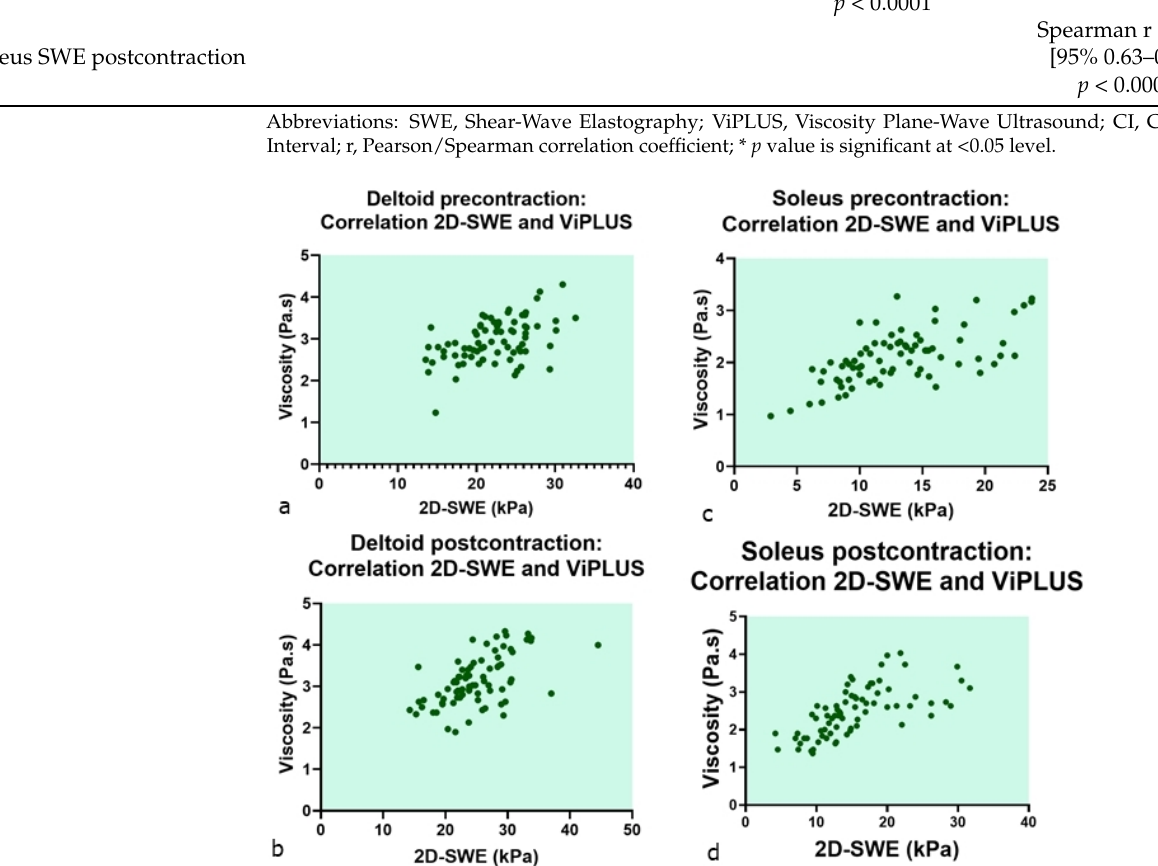
Table 5. Results of the ICC calculations using a mean of two raters, an absolute agreement, and a two-way random-effects model [23].